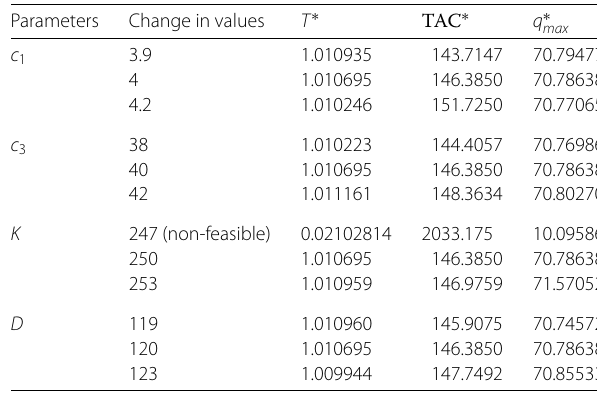
Table 8 Sensitivity table for Case 6.4 for fixed α = 0.5 and β =